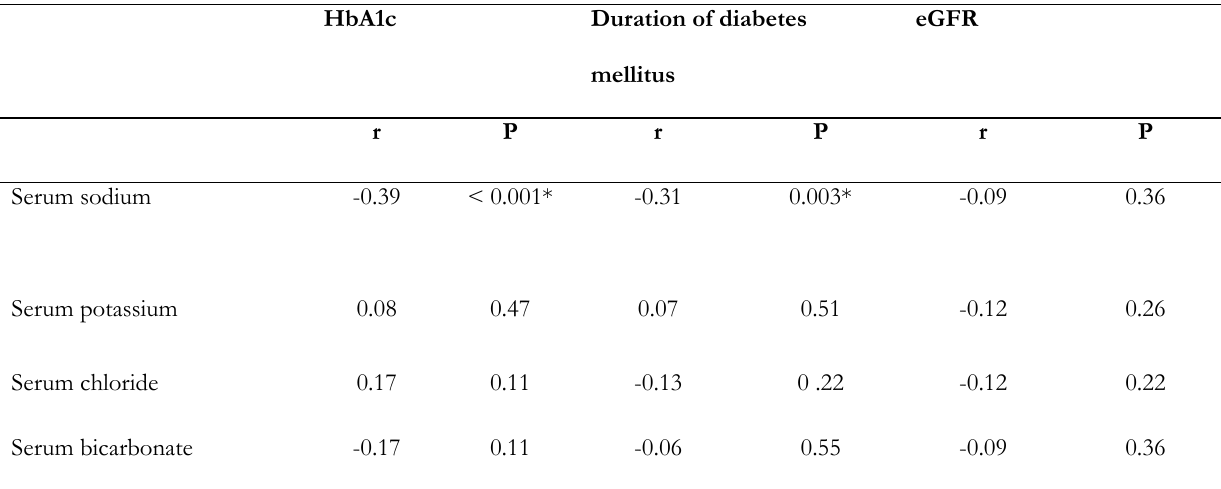
Table 5 Correlation of serum electrolytes with HbA1c, duration of diabetes and eGFR in patients with diabetes mellitus/group 1 (n =